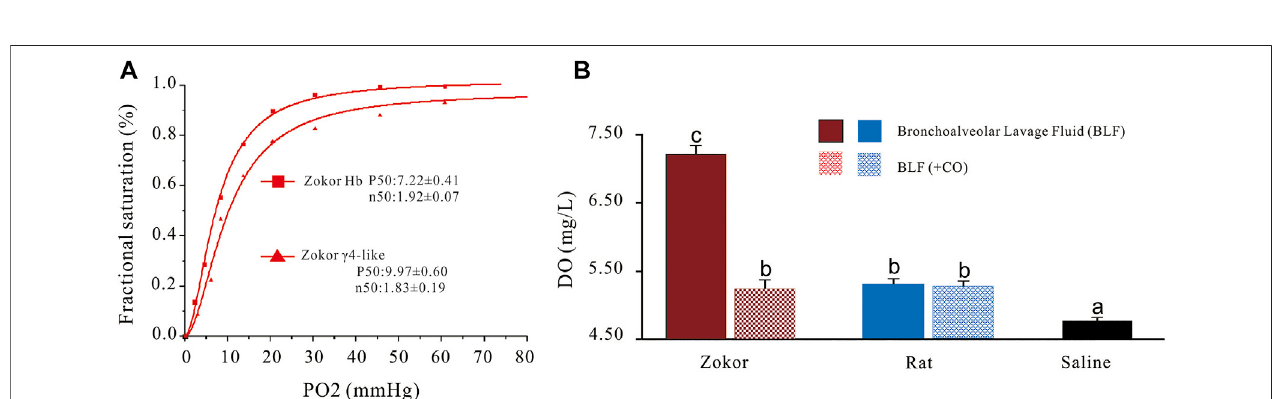
FIGURE5 | The oxygen dissociation curve of γ 4 -likeand its effect onthe dissolved oxygen content in thePS ofplateau zokors. (A) The oxygen dissociation curves of γ 4 -like and Hb of plateau zokor. (B) The dissolved oxygen contents in the PS solutions of plateau zokors and SD rats after being aired and ventilated with carbon monoxide (CO) for 5 min ( n = 6). The saline was used as control